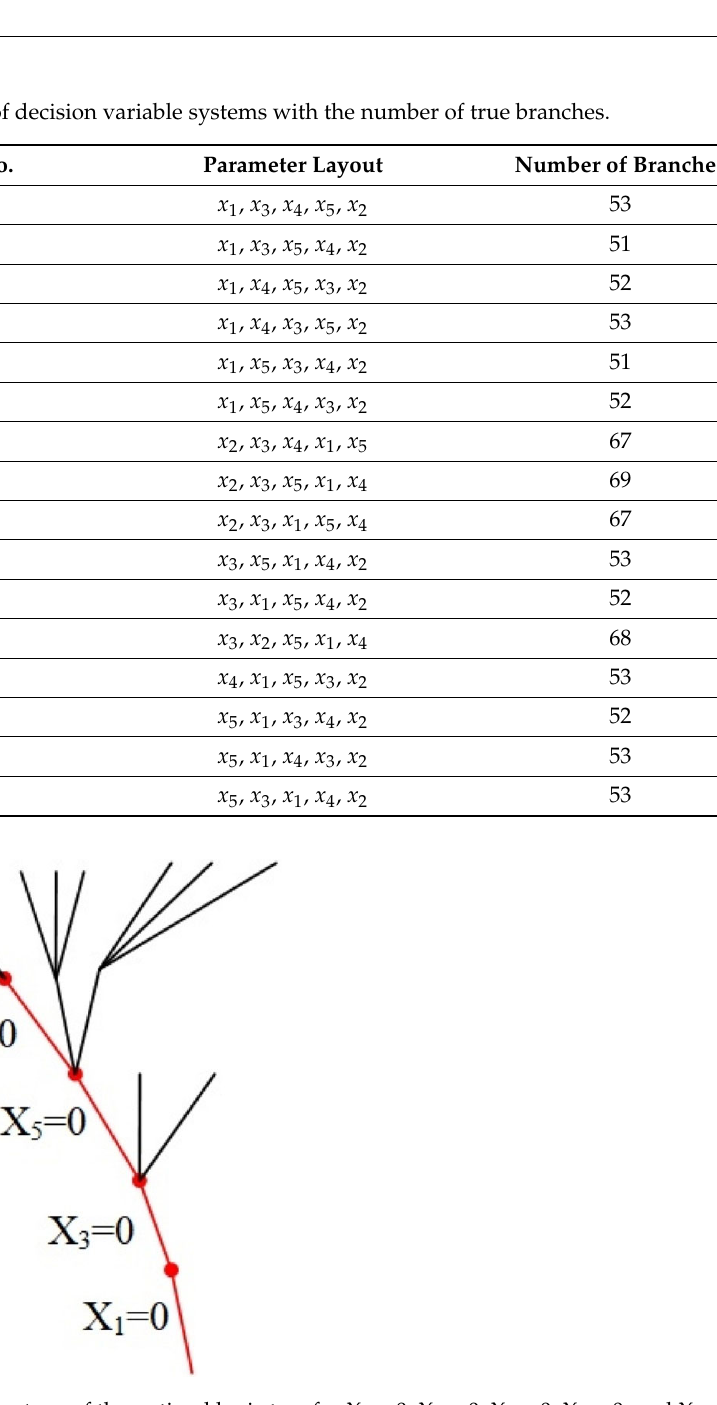
1 = 0, X 3 = 0, X 5 = 0, X 4 = 0, and X 2 =